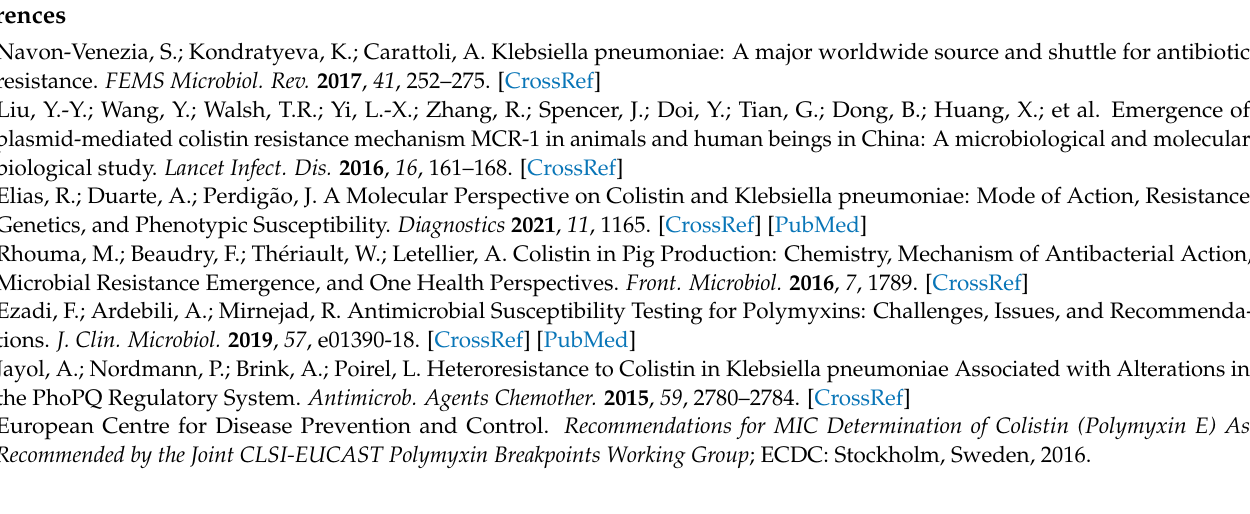
Supplementary Materials: The following are available online at https://www.mdpi.com/article/10.3 390/diagnostics11122352/s1, Figure S1: Colistin MTS results of Kp4129 (A); Kp4129 resistant subpop- ulation (6 µ g/mL) (B); Kp4857 (C); Kp4857 resistant subpopulation (>256 µ g/mL) (D); Kp5509 (E); Table S1: Features of Klebsiella pneumoniae isolates used in this article and colistin susceptibility results by broth microdilution, agar dilution and Minimum inhibitory concentration Test Strips